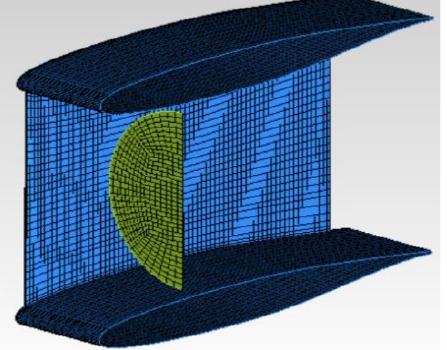
Figure 18. The mesh of half DFW unit simulation using the virtual disc with momentum sources. In the cruise conditions of the DFW unit simulation, the lift-and-drag coefficients comparison between the actual blade and the momentum disc are shown in Figure 19. The close trend and the marginal numerical difference of the coefficients demonstrate the consistency of the actual blade and the momentum disc.